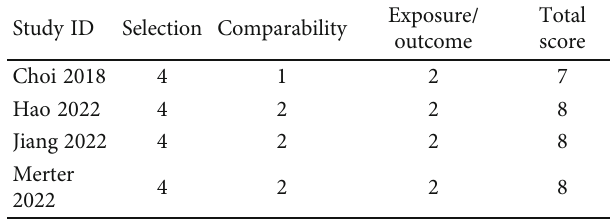
Table 2: Quality assessment of studies included according to the Newcastle-Ottawa